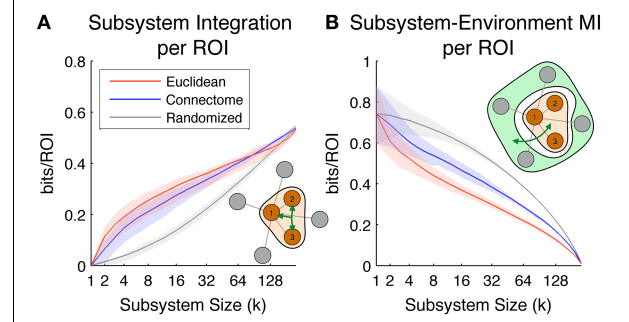
FIGURE 6 | Scaling of the subsystem predictability measures. Colored lines indicate mean values across all subsystems, while shaded areas indicate values within 1st and 3rd quartile. Red, blue, and gray colors correspond to subsystems chosen according to Euclidean, Connectome and Randomized metrics respectively. (A) Subsystem integration per ROI, showing total correlation in the joint activity of ROIs in subsystems of different sizes. The illustration in the lower right corner diagrams how this measure is computed for a given subsystem of size 3. (B) Subsystem-Environment MI, showing functional coupling between subsystems and environments for different sizes. The illustration in the top right corner diagrams how this measure is computed for a given subsystem of size 3 and its